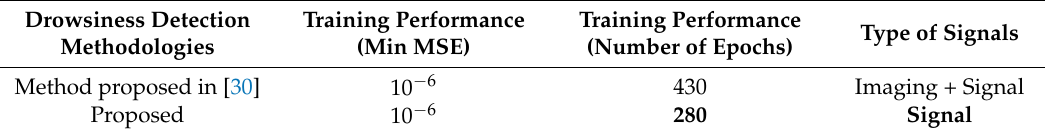
Table 2. Performance comparison with respect to such similar methods described in Reference